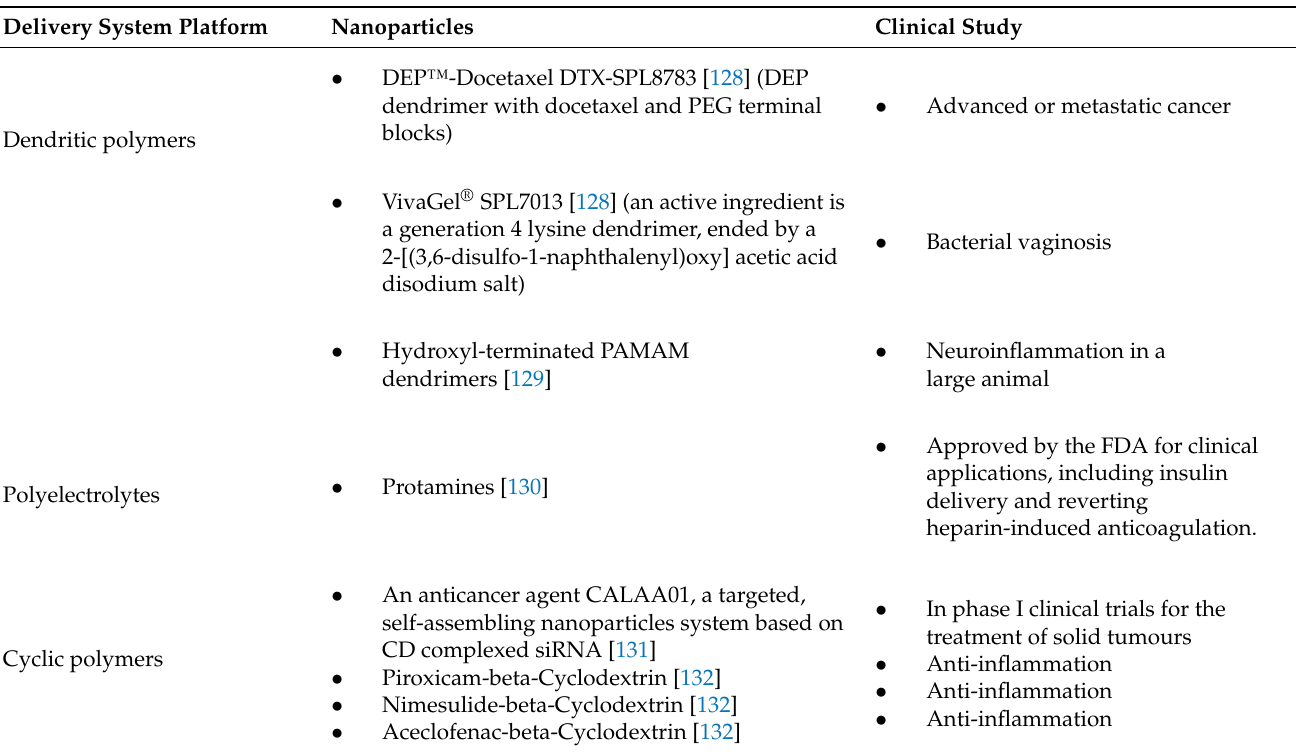
Table 2. Clinical studies on the reviewed smart nanoparticles